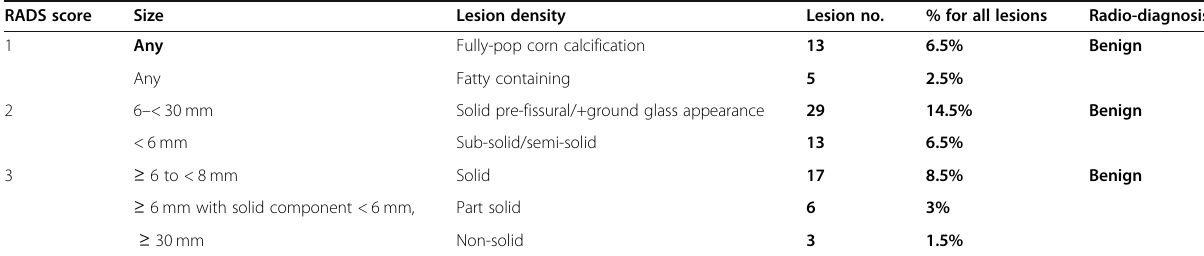
Table 4 Categorization of benign lung nodules (lung-RRADS score 1 – 3): “ group I ” (no. = 86 nodules) RADS